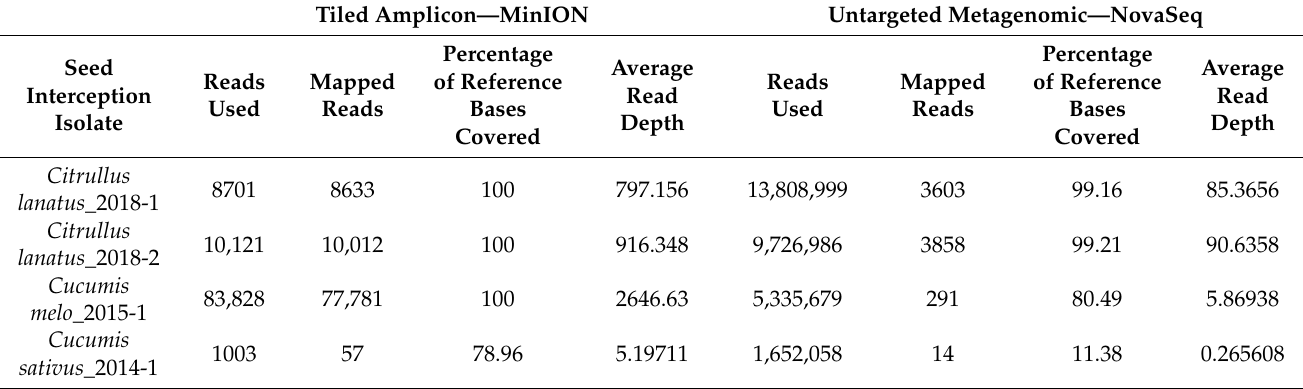
Table 3. The seed interception samples that were tested by tiled amplicon nanopore sequencing and the untargeted metagenomic short read sequencing methods. Tiled amplicon and the untargeted metagenomic sequence data is presented for the number of sequence reads generated for each sample after quality and length trimming, number of reads mapping to the 6377 nt reference CGMMV sequence (GenBank Accession KY115174.1), percentage (%) of CGMMV reference sequence bases covered, and average number of reads at each reference base (Average read depth).